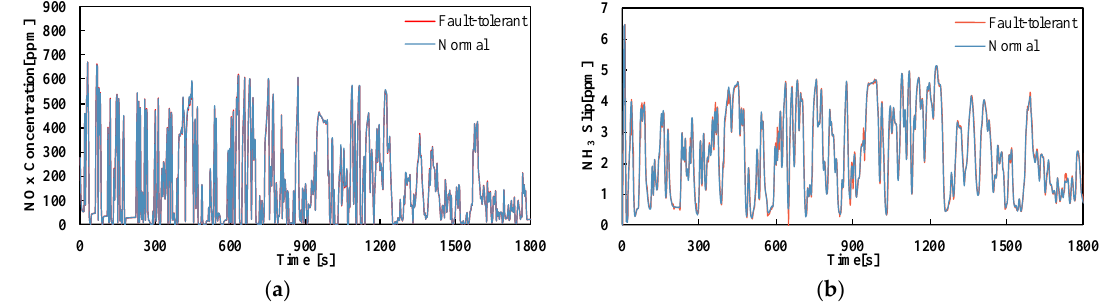
Figure 14. SCR performances under fault-tolerant control. ( a ) NO x concentration; and ( b ) NH 3 slip.